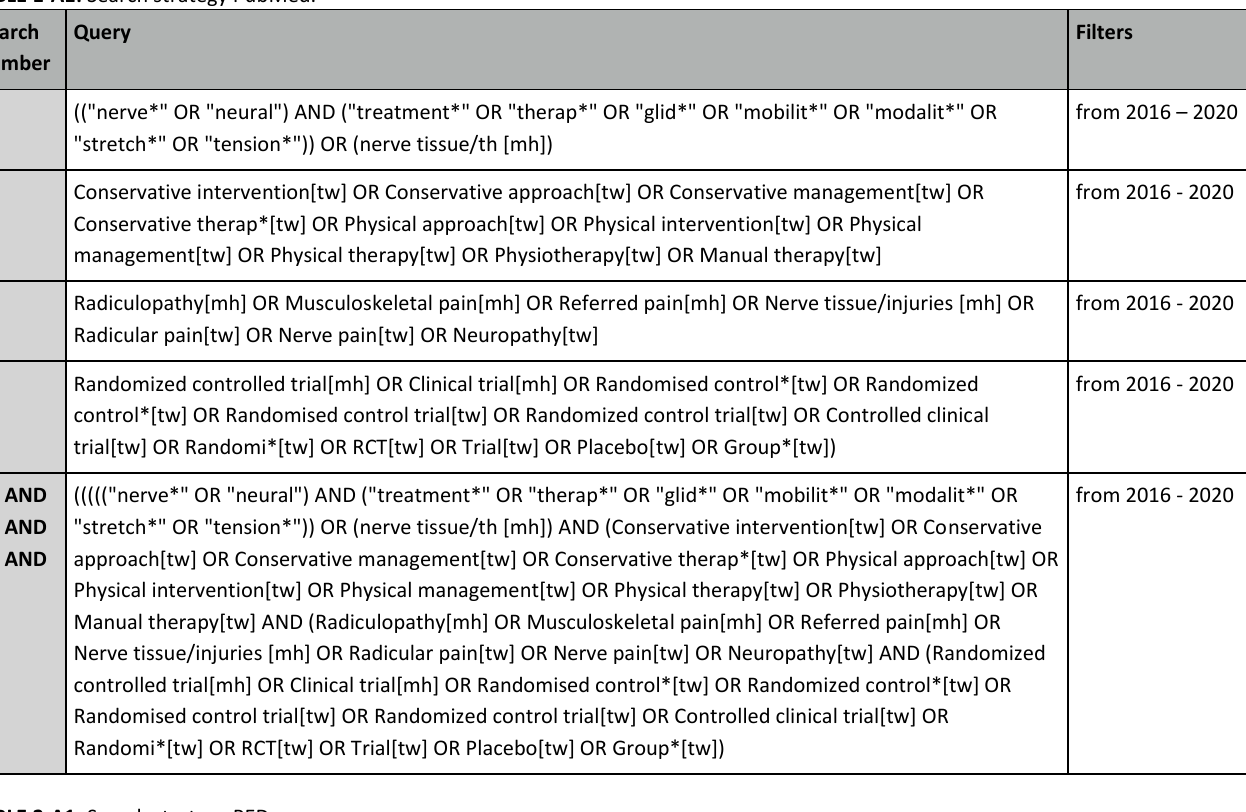
TABLE 2-A1: Search strategy